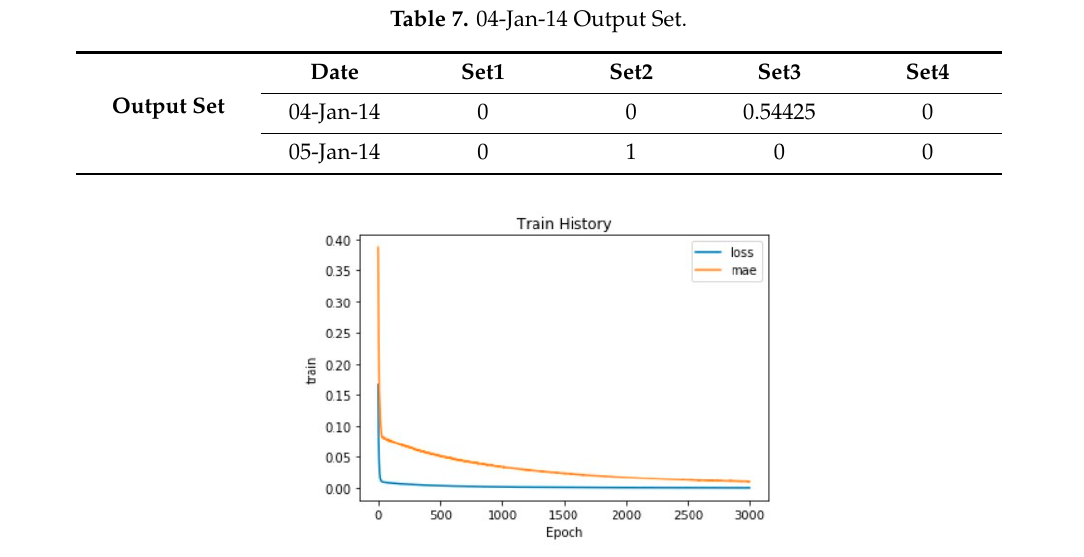
Table 6. 04-Jan-14 Input Set.